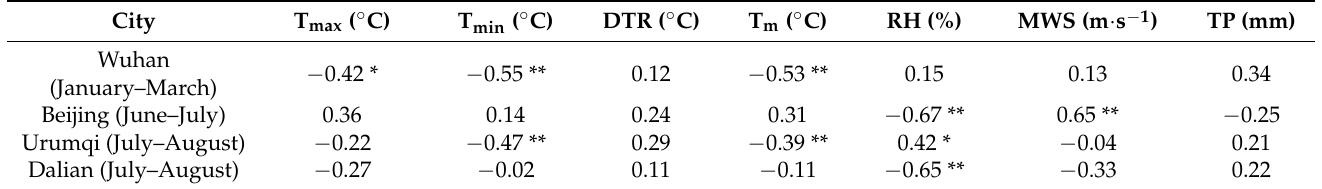
Table 3. Pearson correlation between meteorological factors and COVID-19 infected cases in four cities. Definitions of T max , T min , DTR, T m , RH, MWS and TP are presented in Figure 1; * p < 0.05; ** p < 0.01; *** p < 0.001. City T max ( ◦ C) T min ( ◦ C) DTR ( ◦ C) T m ( ◦ C) RH (%) MWS (m · s − 1 ) TP